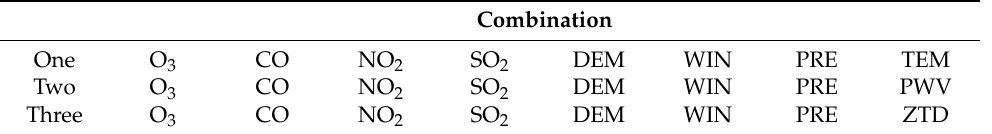
Table 2. Variable Combination Scheme.